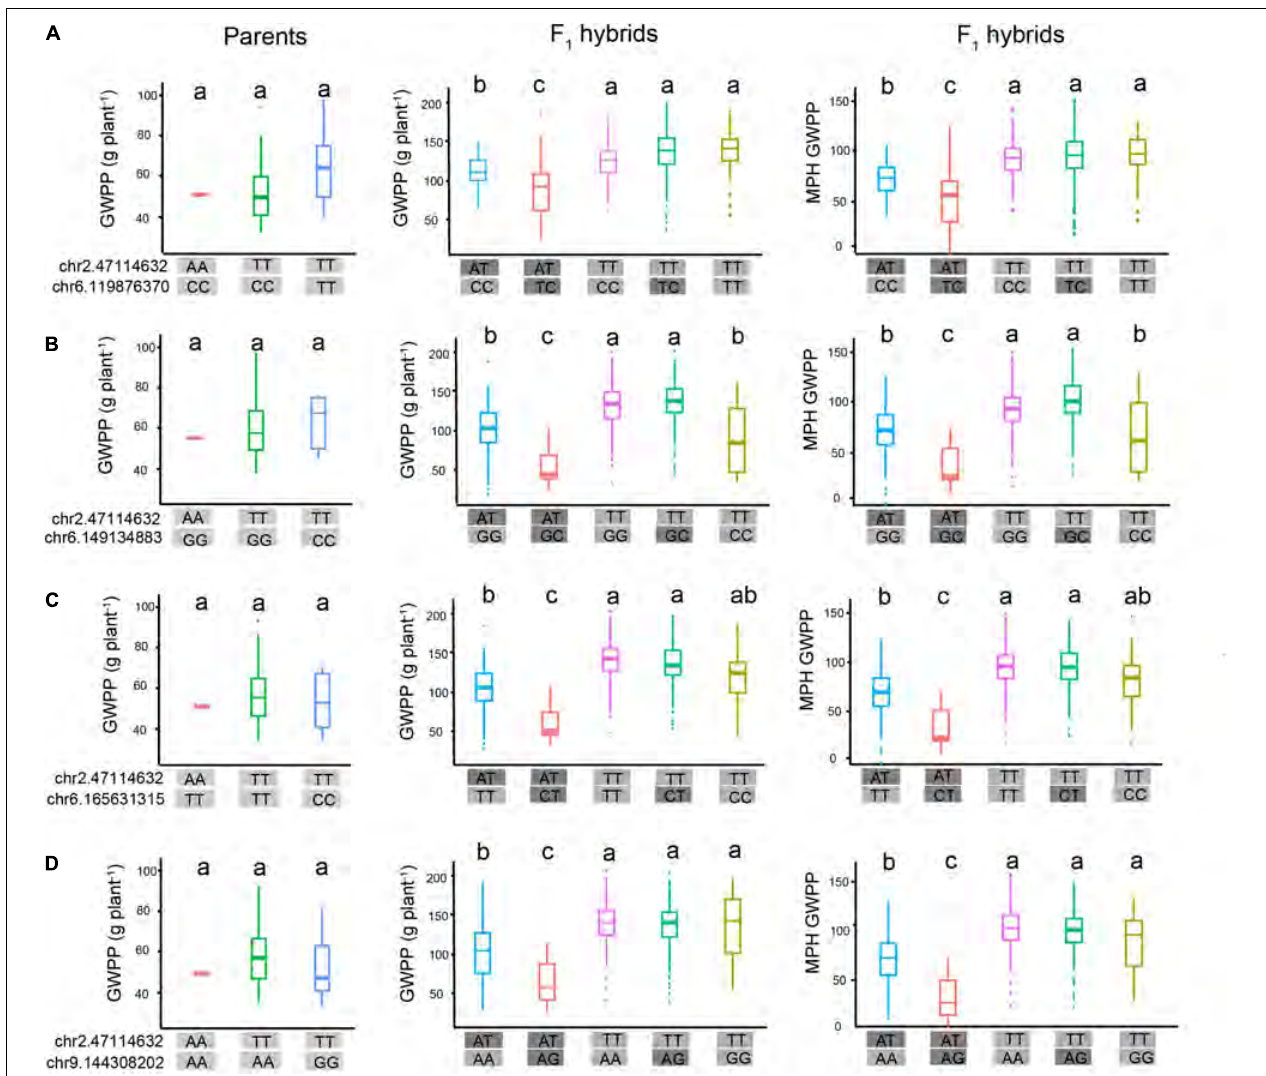
FIGURE 9 | Hypothetical model of epistatic effects affecting heterosis of grain weight per plant (GWPP). Epistatic interaction between chr2.47114632 and four loci contributes to the heterotic performance of GWPP in F 1 hybrids. (A) In the parental lines (left panel), the three haplotypes showed similar GWPP, indicating that there was no interaction between chr2.47114632 and chr6.119876370. In the F 1 hybrids (middle panel), the genotype chr2.47114632-TT (rose red boxes, green boxes, fluorescent green boxes) exhibited higher GWPP, indicating that chr2.47114632-TT activated a strong positive additive/dominance induced epistatic effect with the locus chr6.119876370 in F 1 hybrids, and chr2.47114632-TA exhibited lower GWPP (blue boxes, red boxes), indicating that chr2.47114632-TA activated a weak epistatic effect with the locus chr6.165631315 in F 1 hybrids. Panels (B–D) present the epistatic interactions between chr2.47114632 and three other